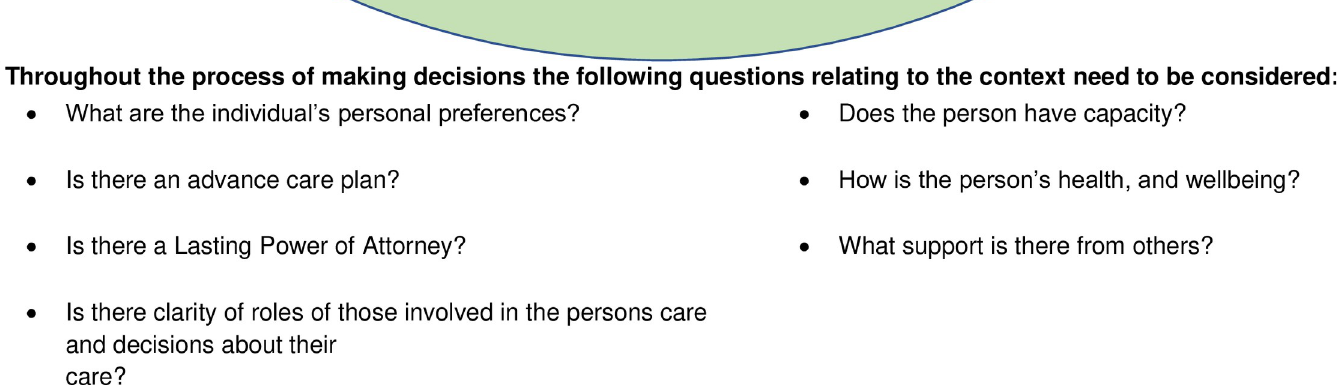
Fig 1. Conceptual model of decision-making in dementia EOLC.